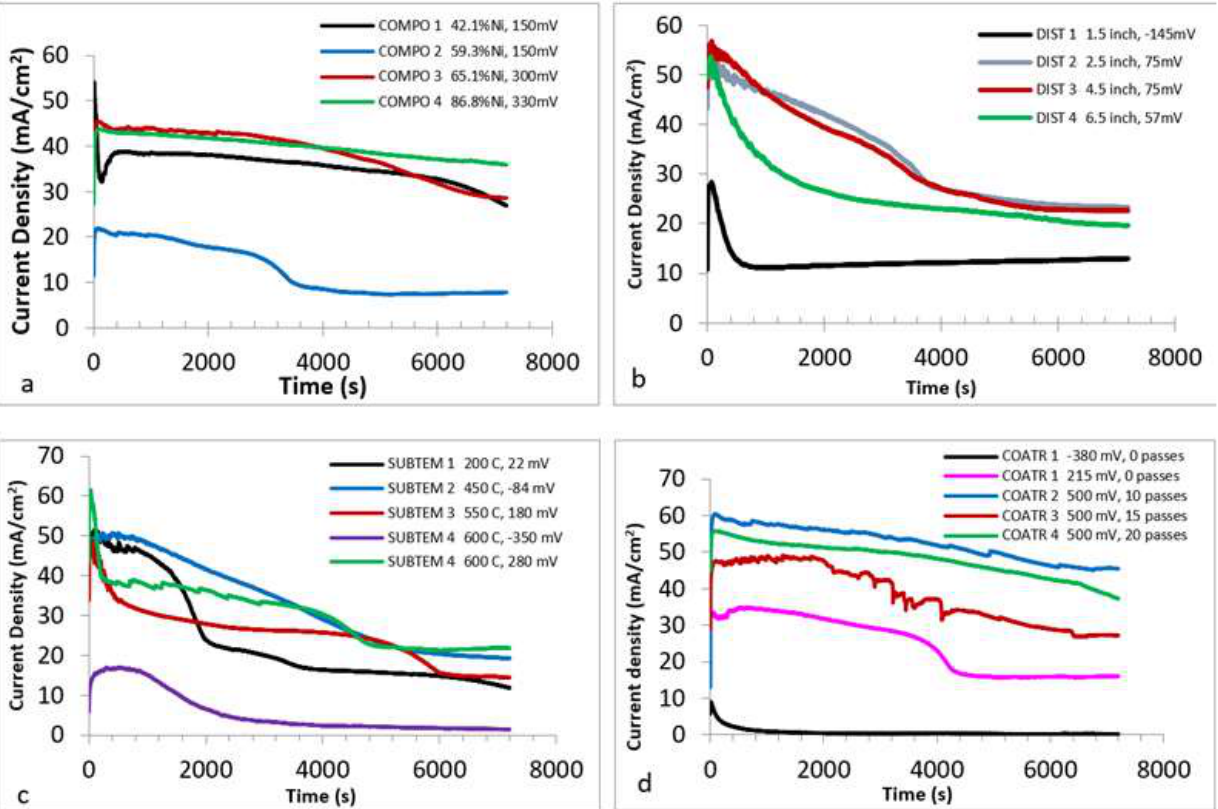
Figure 13. Chronoamperometry plots of the nickel aluminide coatings at pseudopassive potentials (as determined by potentiodynamic polarization) varying: ( a ) the initial mixture composition (%wt. Ni), ( b ) the thermal spraying distance, ( c ) the substrate temperature and ( d ) the thermal treatment of the coating. All specimens were immersed in 3.5% NaCl at 25 °C.